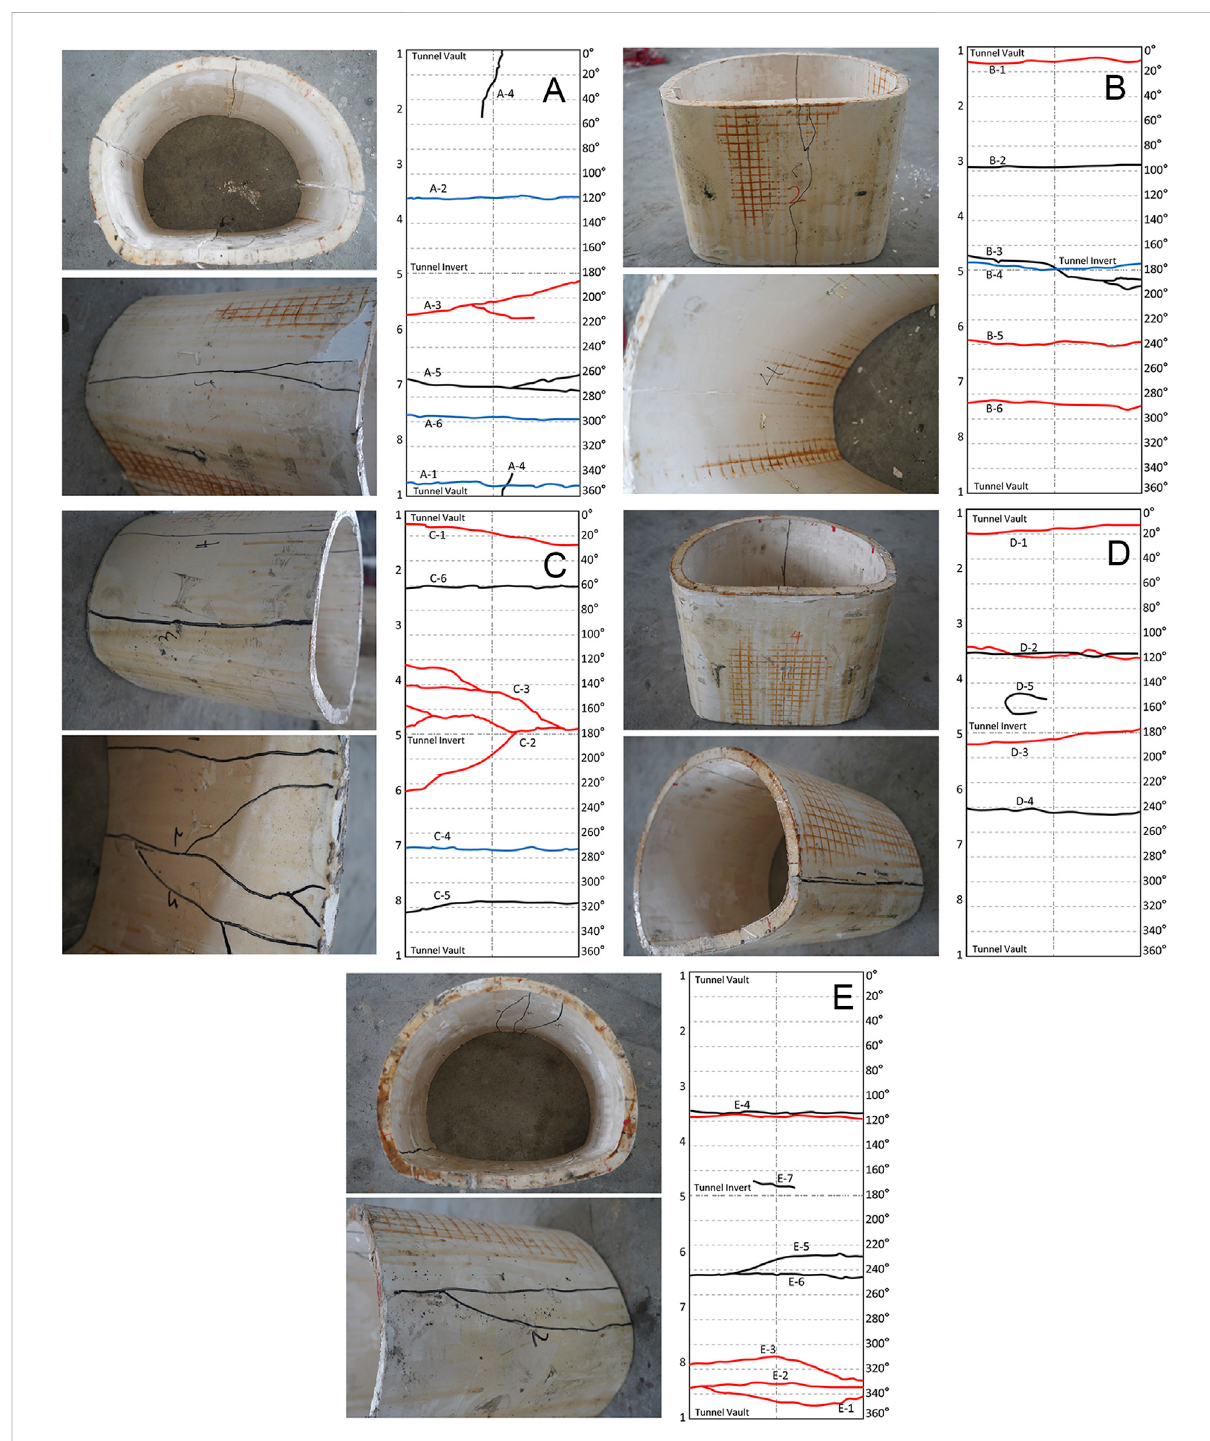
FIGURE 13 Diagram of the damage pattern of the lining